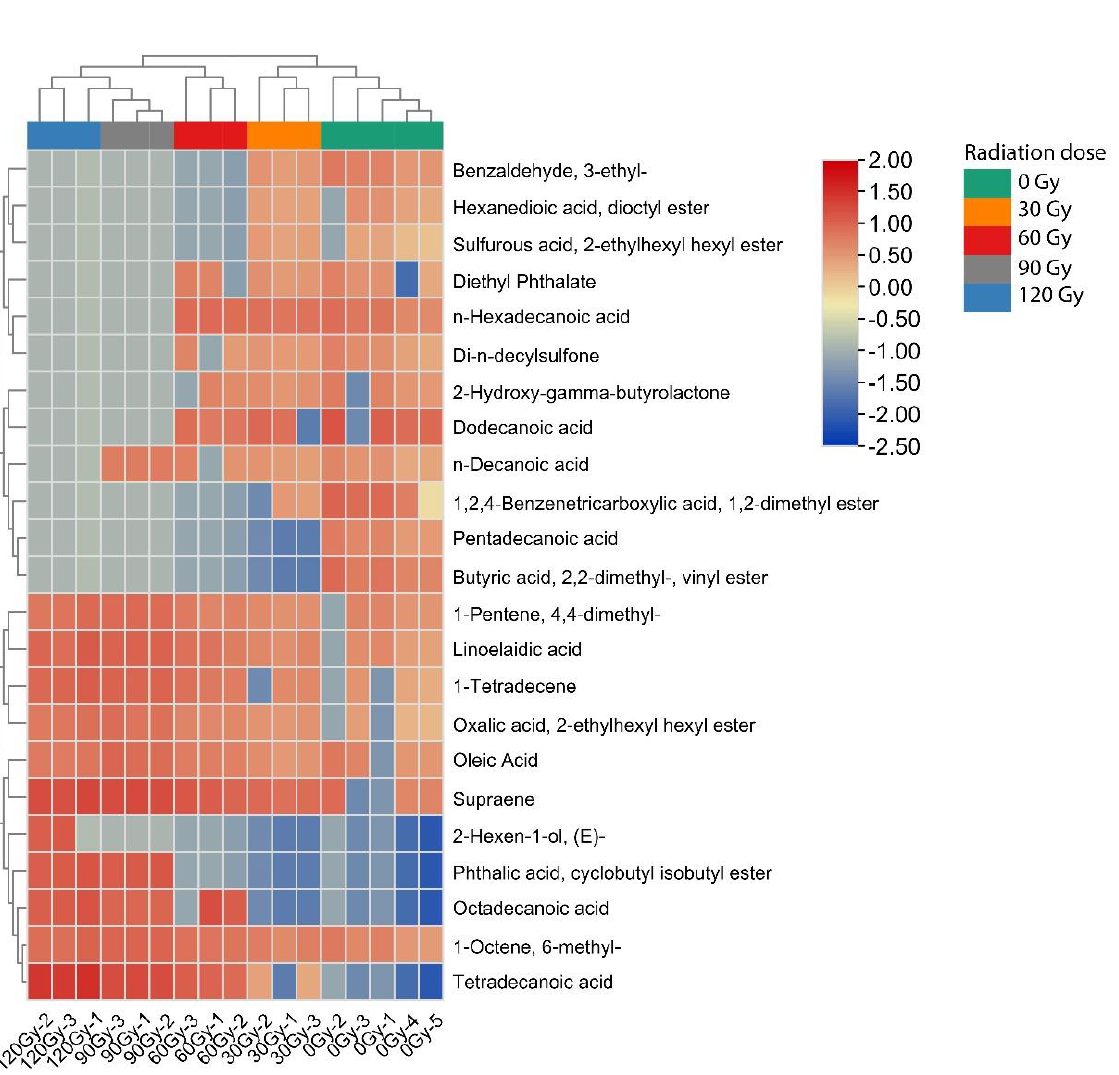
Figure 2. Clustering heatmap of metabolites in B. dorsalis larvae exposed to different doses of irradiation treatment.